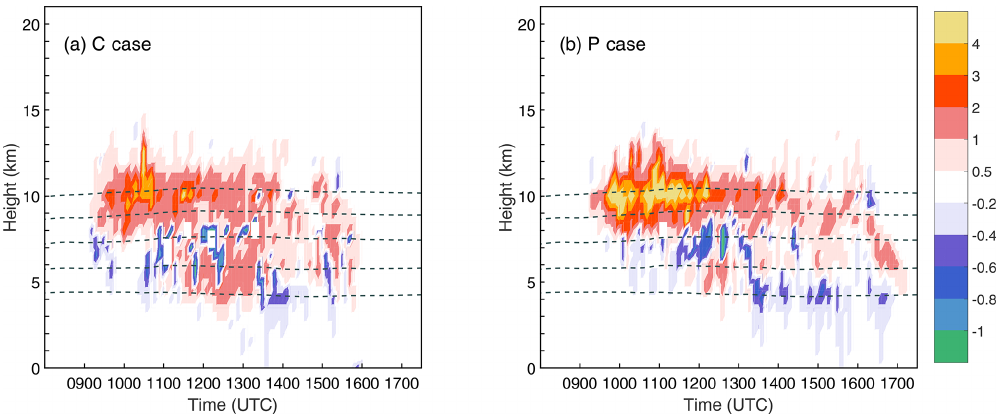
Figure 13. Temporal variation in the vertical profiles of peak positive (negative) charge density (nCm − 3 , shaded) of (a) C case, and (b) P case. The 0, − 10, − 20, − 30 and − 40 ◦ C isotherms are shown by the dashed gray lines in (a) – (b)